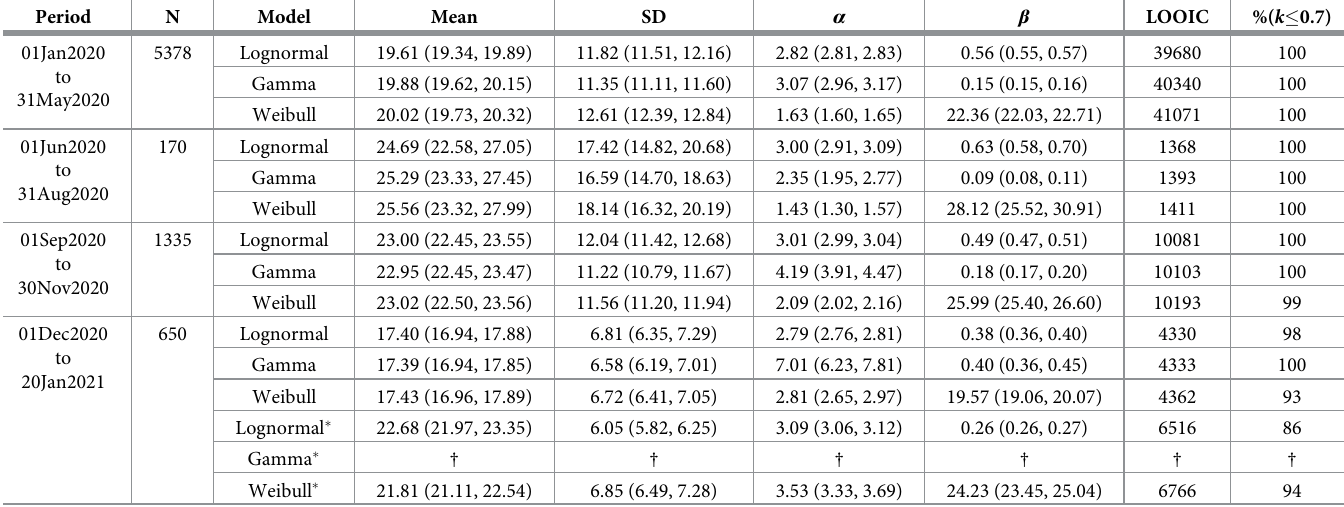
For the last time period from 1 December 2020 to 20 January 2021, the right truncated model was run as well. 90% credible intervals are quoted. � Model run with right truncation using r =